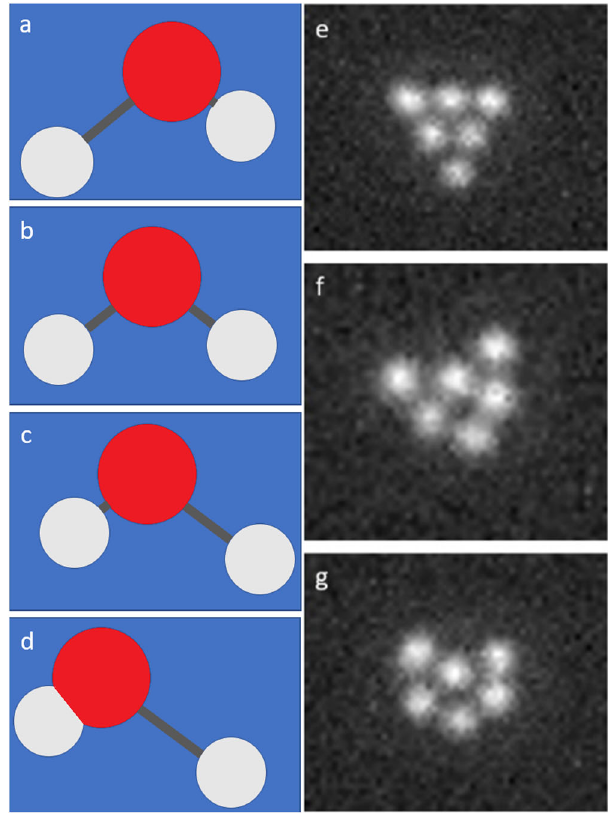
Fig. 1 An analogy between molecular normal modes and the collective modes of optical matter systems. a – d The antisymmetric stretching mode of the water (H 2 O) molecule. e – g Experimentally measured “ instantaneous ” OM con fi gurations associated with a transition between triangle ( e ) and chevron ( g ) via and intermediate higher energy transition con fi guration ( f ) in the 6-particle optical matter system that forms and fl uctuates in a converging Gaussian optical beam that is circularly